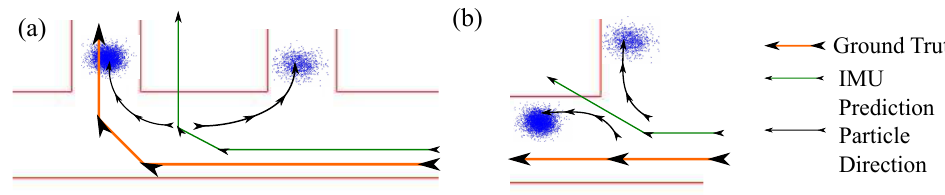
Figure 3. Both ( a ) and ( b ) demonstrate how the particle cloud can diverge. This clearly shows how computing a direct average will yield inaccurate results, as in this case it will give a location situated in an impassible terrain feature. By applying a clustering algorithm, it is possible to exclude the smaller particle cloud from influencing the calculated